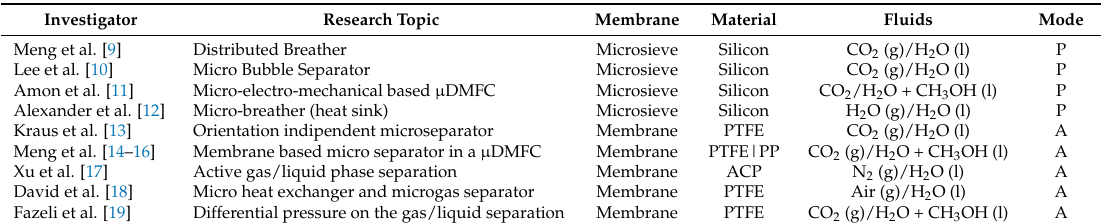
Table 1. Examples of previous works on the gas/liquid separation in microstructured devices using polymeric membranes or inorganic microsieves as a separation